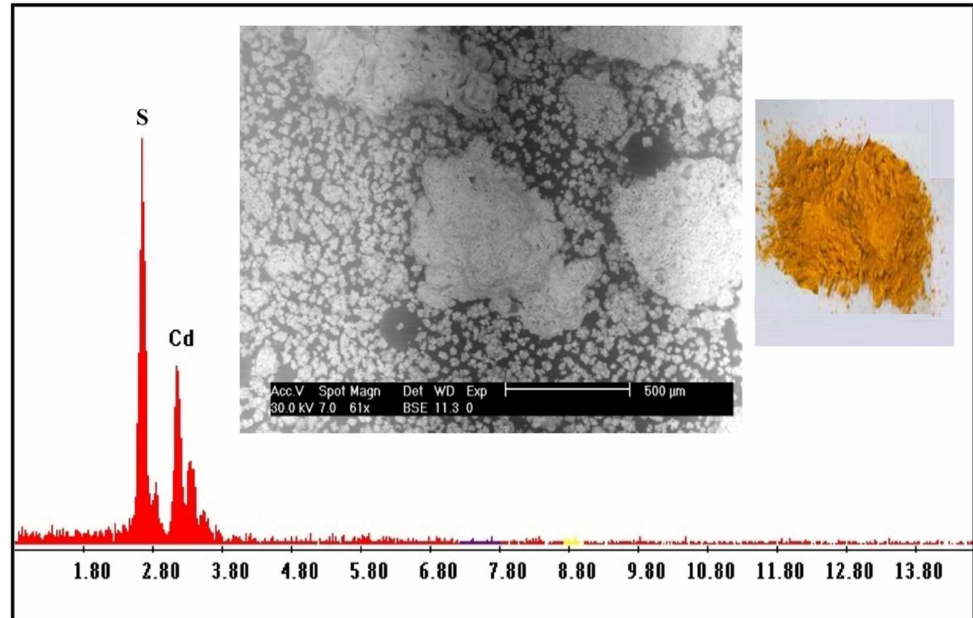
Figure 4. SEM-EDX chart for CdS